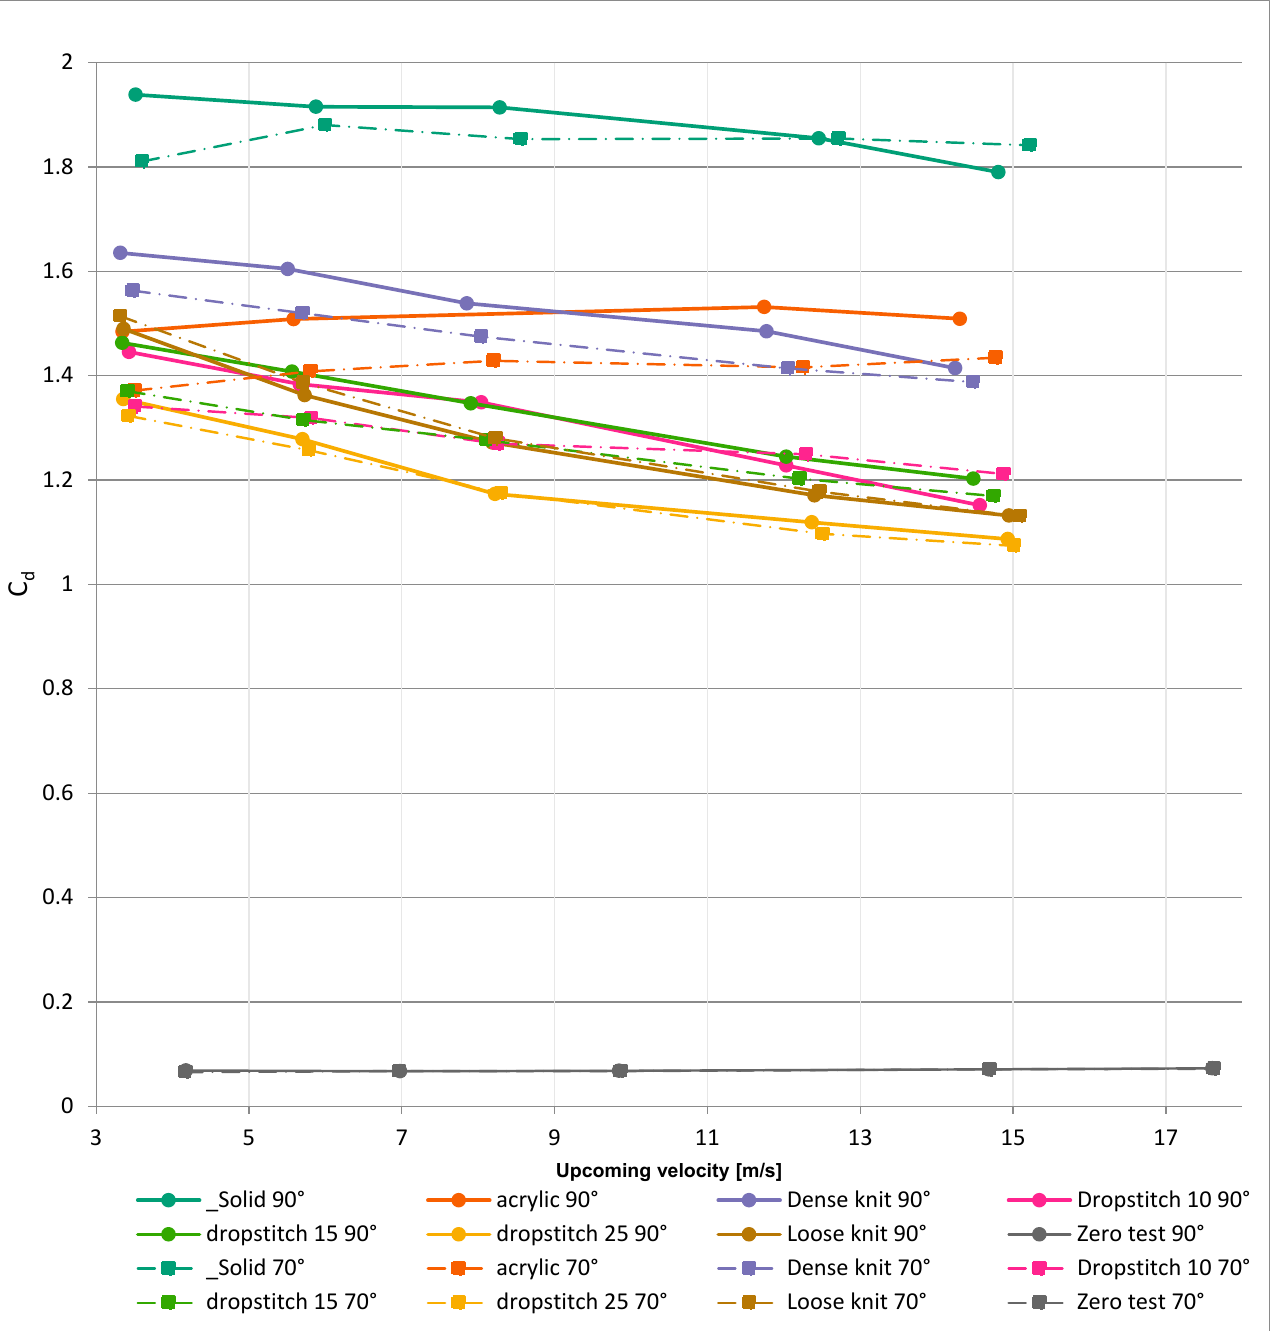
Figure 19. Drag coefficient, C d, for the models.